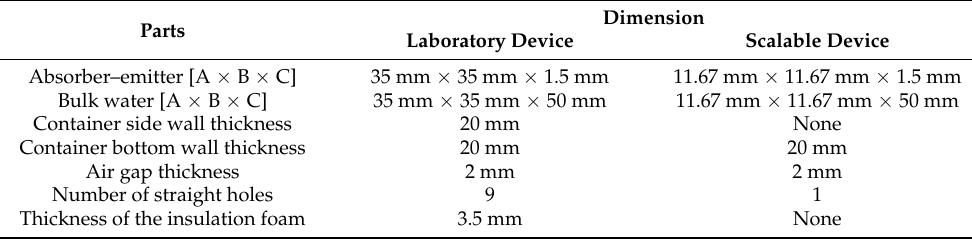
Table 1. Geometrical parameters of the laboratory and scalable devices.